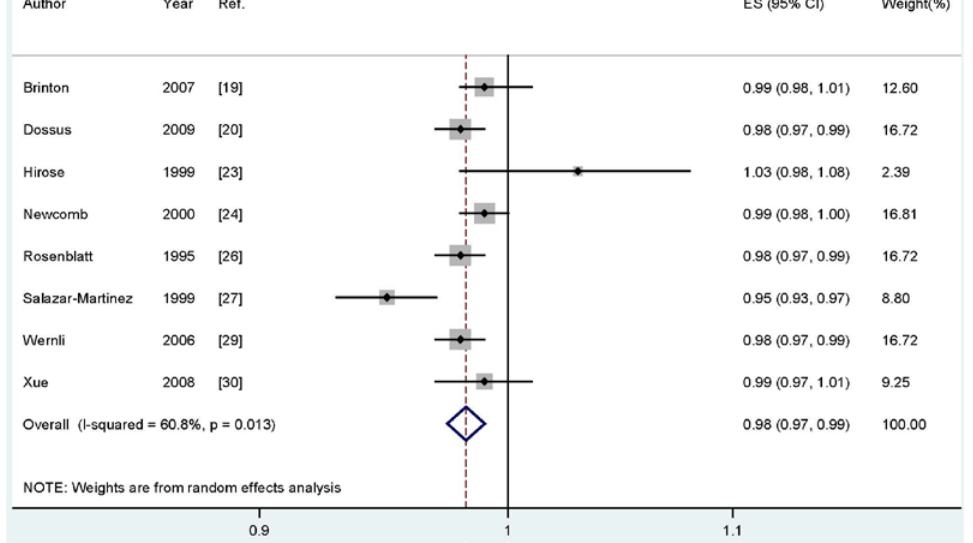
Figure 4. Analysis of influence of individual study on the association between breastfeeding and endometrial cancer risk. Open circles represent the pooled RR and horizontal lines represent the 95% CIs.